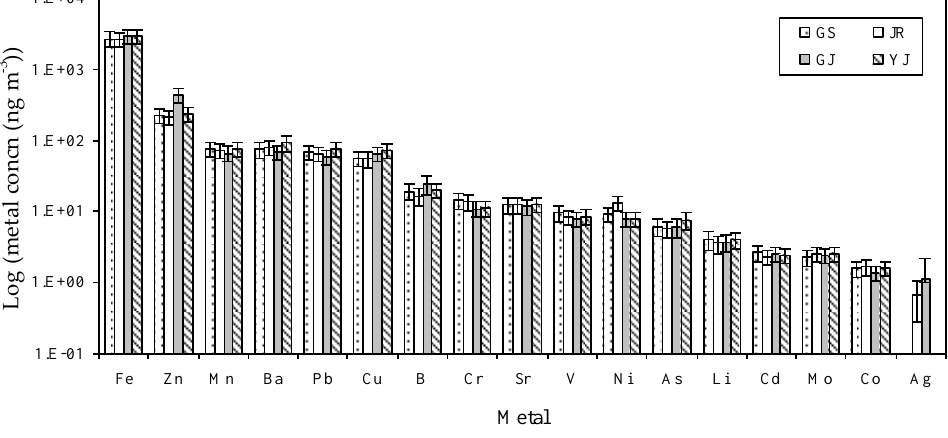
FIGURE 3. Comparison of the mean metal concentration in TSP across the four study